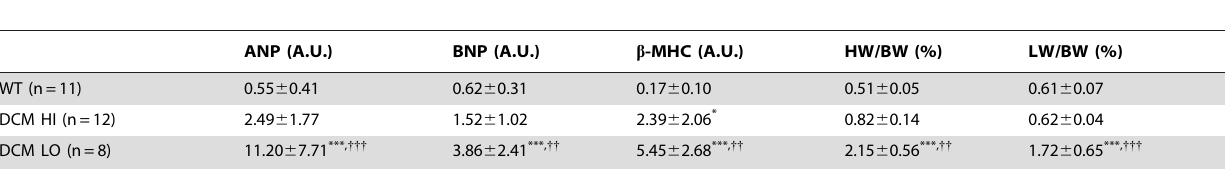
Table 2. Expression of ANP, BNP, and b -MHC levels and HW/BW and LW/BW ratios in myocardium from WT and HI and LO groups of DCM